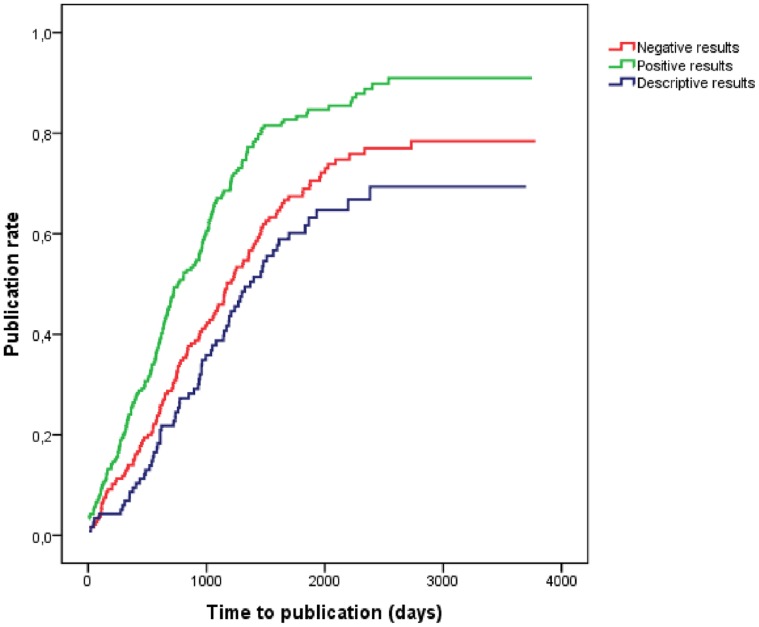
Kaplan Meier survival curves of time to publication sorted by study outcomes (positive, negative, descriptive).